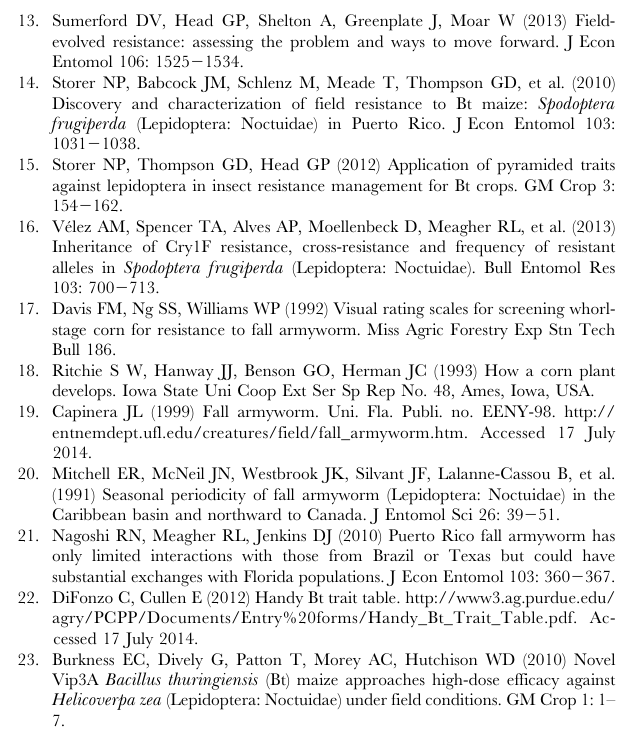
Table S2 Plant injury and larval survival of a Cry1F- susceptible (SS-FL) strain and three Cry1F-resistant families (LA-RD-24, LA-RD-34, and FL-39) of Spodoptera frugiperda on whole plants of non-Bt and Cry1F maize hybrids in the greenhouse. Table S3 Leaf injury ratings (mean ± SEM) of non-Bt and HX1 plants caused by feral populations of Spodop- tera frugiperda in a field trial in Collier Co., FL in 2012. Table S4 Leaf injury rating and survival (mean ± SEM) of Cry1F-susceptible strain (SS-FL) and a field popula- tion (FL-CL-NBt-2012) of Spodoptera frugiperda collected from non-Bt maize from a field in Collier Co., FL in 2012 and tested in the greenhouse. Table S5 Correlation coefficients of larval survivorship of 142 two-parent families of Spodoptera frugiperda in an F 2 screen with maize leaf tissue containing single or pyramided Bt genes. Table S6 Baseline survivorship (mean ± SEM) of a susceptible strain (SS-FL) of Spodoptera frugiperda on leaf tissue of Bt and non-Bt maize plants. Table S7 Potential positive families (PPF) possessing resistance alleles (RAs) to Cry1F maize that were identified in the F 2 screen in three populations of Spodoptera frugiperda collected from Louisiana (LA) and Florida (FL).